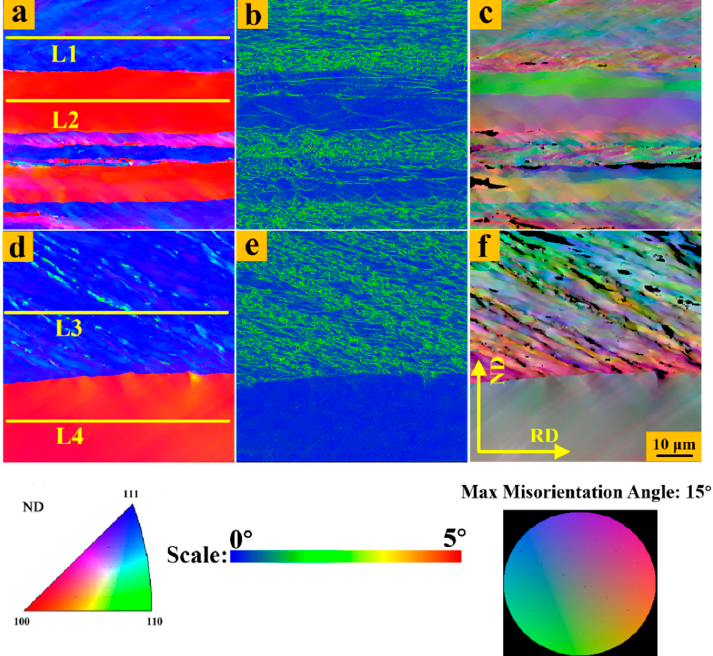
Figure 5. Microstructure of 87% UR-Ta in the regions ‘R1’ and ‘R3’, respectively. ‘R1’: ( a ) IPF map; ( b ) kernel average misorientation (KAM); ( c ) grain reference orientation deviation-hyper (GROD- Hyper). ‘R2’: ( d ) IPF map; ( e ) KAM; ( f )